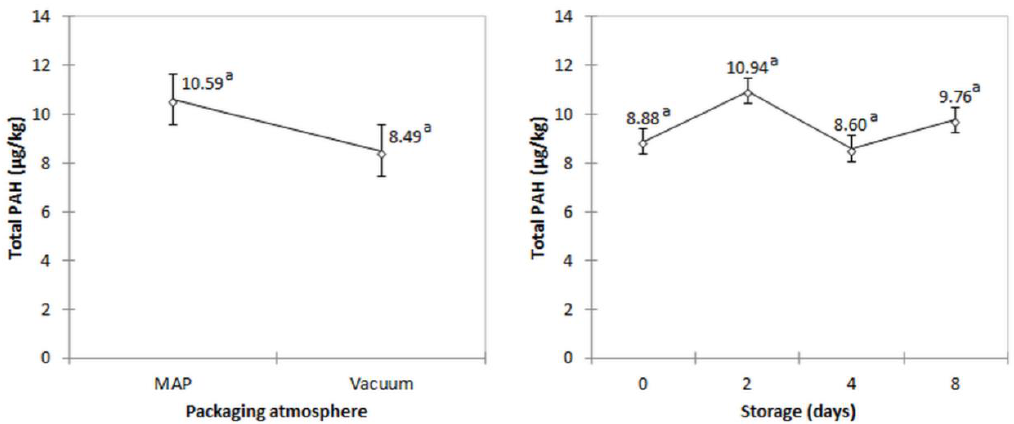
Figure 3. Total PAH in fried fresh-cut potato as affected by the cultivar, anti-browning agent, packaging and storage duration. Results are expressed as mean ± SE of n = 16 for cultivars, anti-browning agents, package atmospheres and n = 8 for days. Values with different letters are statistically different at p ≤ 0.05.